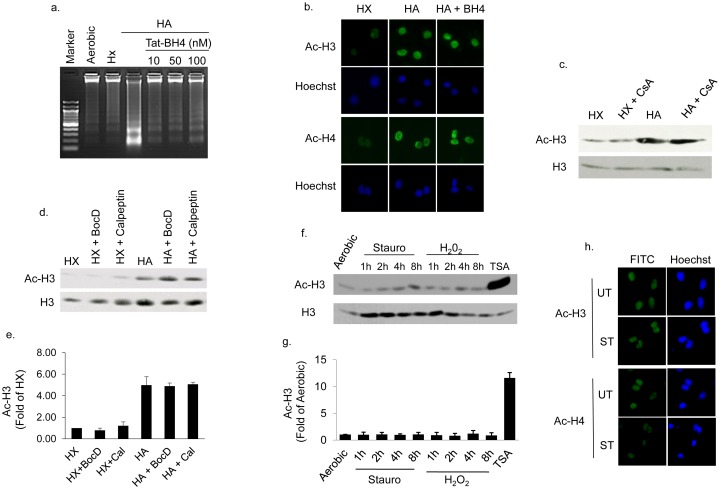
Histone hyperacetylation is independent of cell death.In (A and B), cardiac myocytes were pretreated with mitochondrial permeability transition pore (mPTP) inhibitor TAT-BH4, before exposure to hypoxia or HA, and histone acetylation or DNA fragmentation measured as described in Methods. In (C and D), cardiac myocytes exposed to hypoxia (HX) or hypoxia-acidosis (HA) in the presence and absence of the mPTP inhibitor cyclosporine A (CsA), the caspase inhibitor BocD, or the calpain inhibitor calpeptin as indicated. Western blot quantitation of histone H3 acetylation in the presence of BocD and calpeptin (Cal) is shown in (E). In (F and G) cardiac myocytes were treated with vehicle (UT), or with staurosporine or hydrogen peroxide (H2O2) as indicated, to induce cell death, and the acetylation level of histone H3 was determined by western blot analysis. As a positive control for histone acetylation cardiac myocytes were also treated with the HDAC inhibitor TSA. The effect of staurosporine (ST) treatment on histone H3 and H4 acetylation is shown in (H). All results are mean ± S.E.M., n = 3.